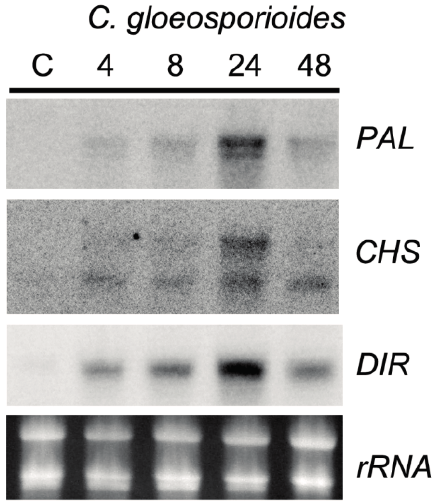
Figure 5. C. gloeosporioides -induced expression of defense genes in P. patens . Expression of phenylammonia lyase ( PAL ), chalcone synthase ( CHS ) and dirigent-like ( DIR ) genes